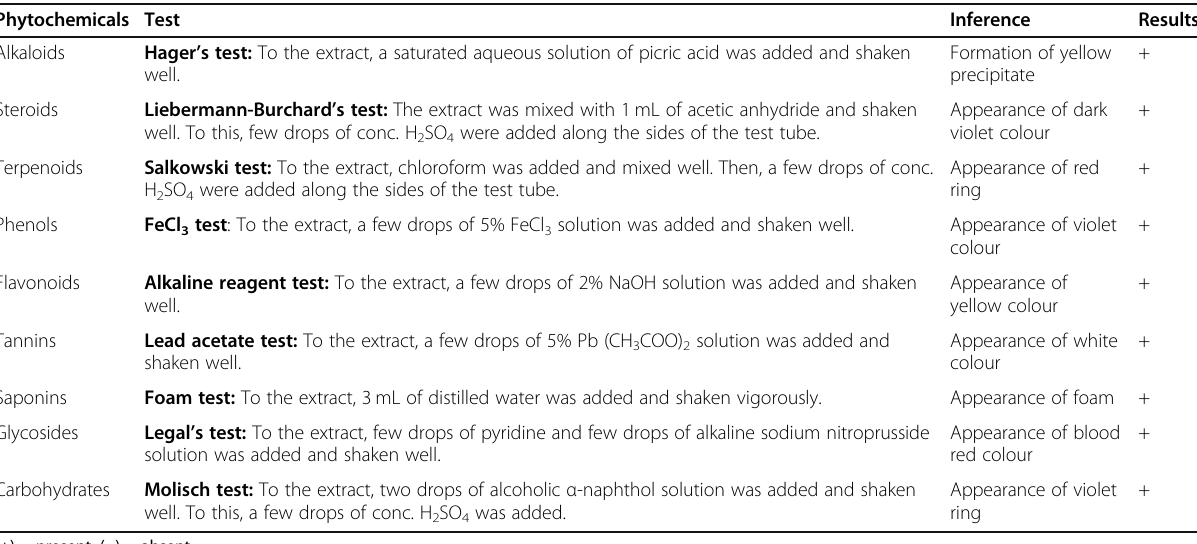
Table 1 Phytochemical analysis summary of root extract of Strobilanthes heyneanus Phytochemicals Test